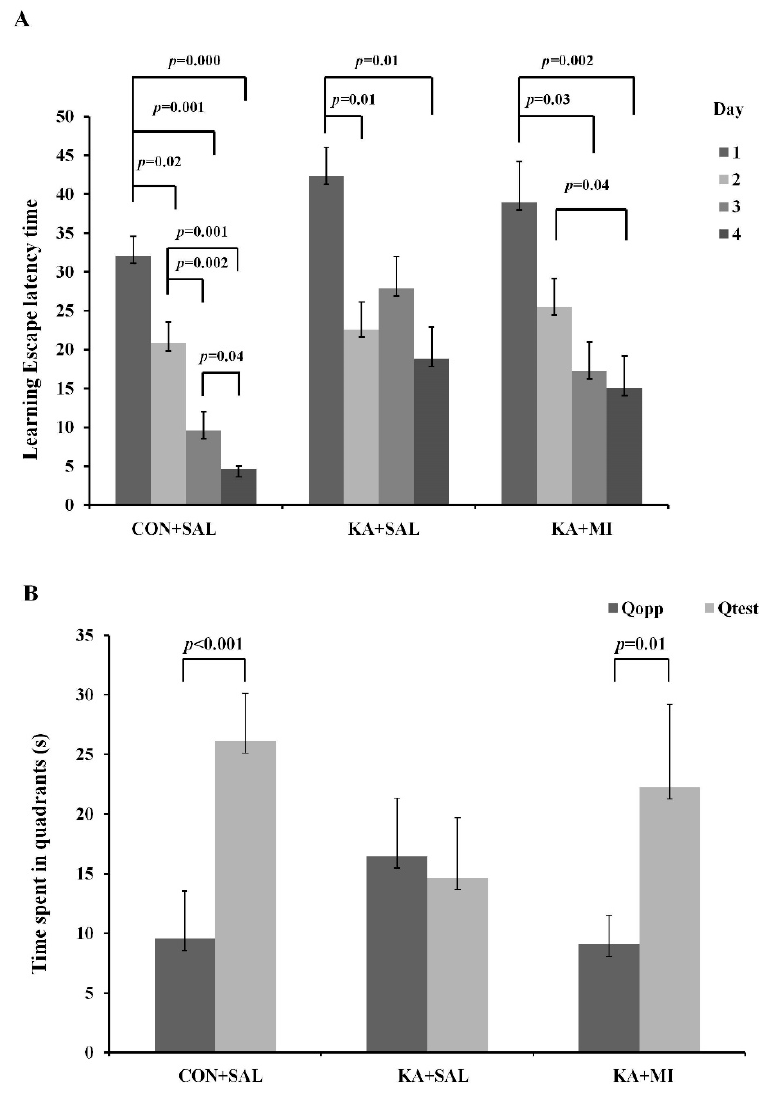
Figure 2. Spatial task learning and memory retention in MWM. ( A )—distribution of the escape latency time (seconds ordinate) separated in treatment group and day. In each boxplot the central bar represents the median of the distribution, while the box covers the 0.25–0.75 interquartile range (IQR). Whiskers extend in both directions from the extremes of the box up to 1.5 times the IQR. ( B )—Distribution of the time spent in each quadrant (seconds, y -axis) separated per treatment group. Distributions are represented through boxplots, as conducted in panel A”.